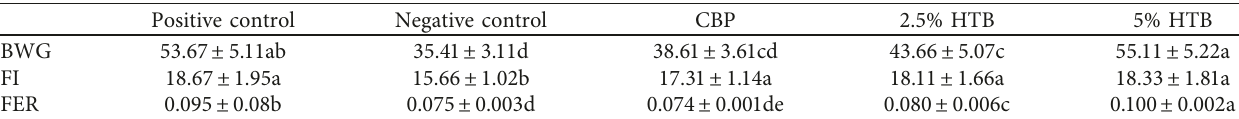
Table 6: Effect of the beef burger fortified with different ratios of husk tomato powder on BWG, FI, and FER of anaemic rats (mean values ± SD).